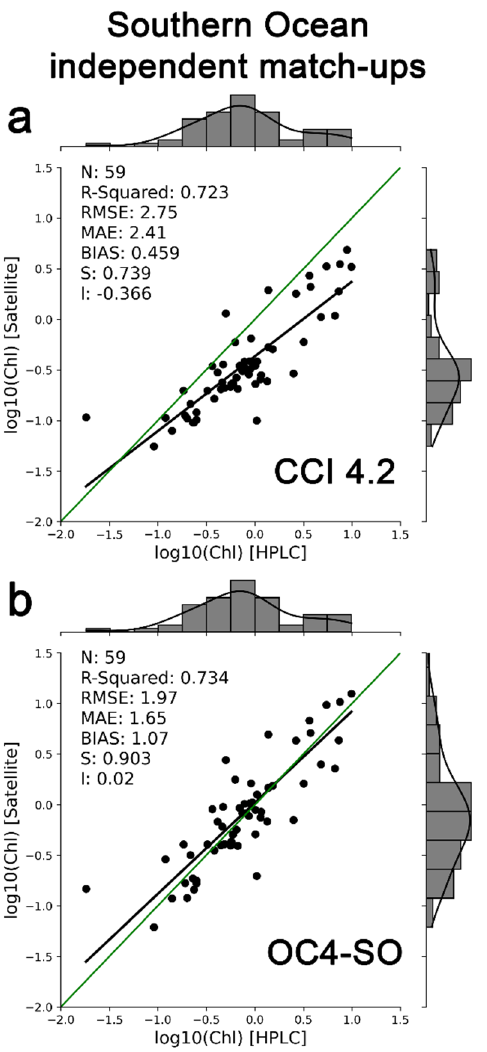
Figure 9. Comparison of the performance of the CCI v4.2 product ( a ) and the OC4-SO algorithm (( b ); this work) for a set of independent match-ups from the Southern Ocean, excluding the Antarctic Peninsula. Note that the axis scale is logarithmic (log 10 ). The green line represents the 1:1 line (ideal correspondence).